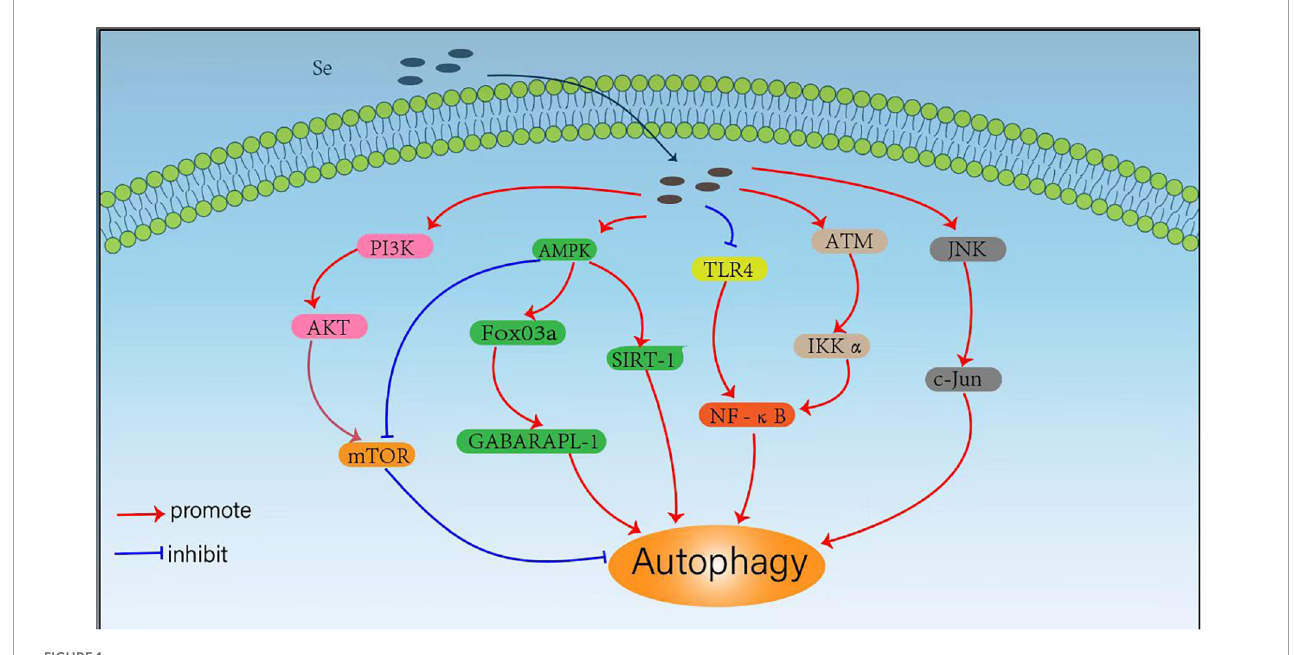
FIGURE1 Mechanisms for selenium (Se) regulated cellular